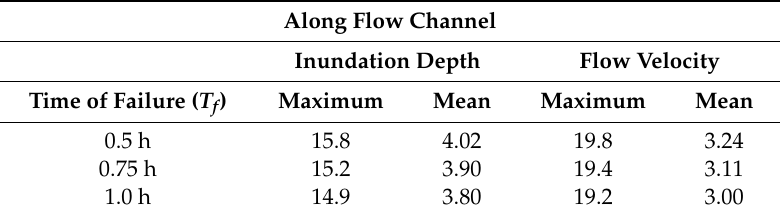
Table 4. Hydraulic properties of potential GLOF at Milam village for varied moraine-failure time.